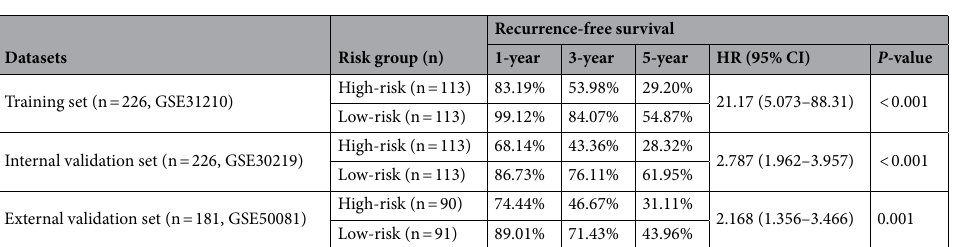
Table 3. RFS analyses by the log-rank test according to the fifteen-mRNA signature in each set. Our result shown lower scores were associated with longer RFS, and higher scores were associated with shorter RFS in each set ( P <